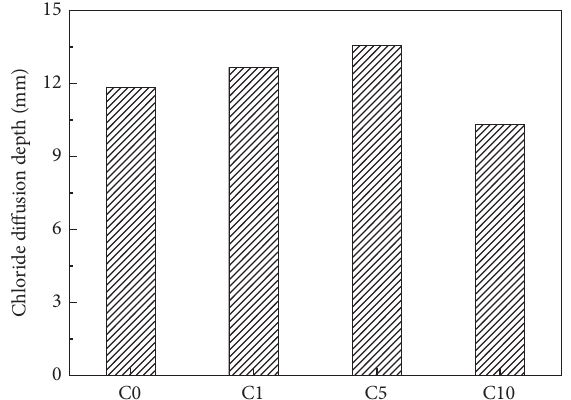
Figure 5: Chloride diffusion depth of CNT-mortar samples with the various dosage of CNT-COOH after 28 days of curing time.